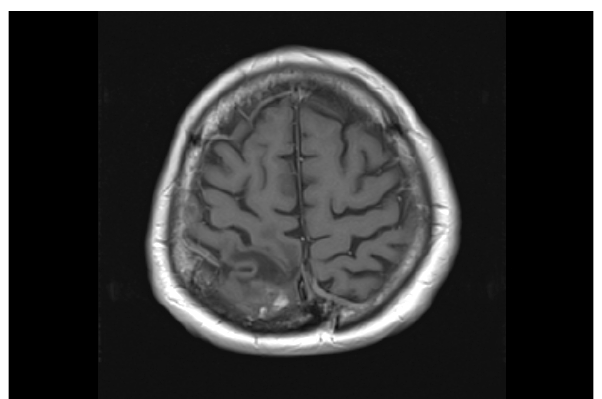
Fig. 3a. Axial T1-weighted MRI scan showing contrast-en- hanced lesion around the original resection cavity in the right parietal lobe.